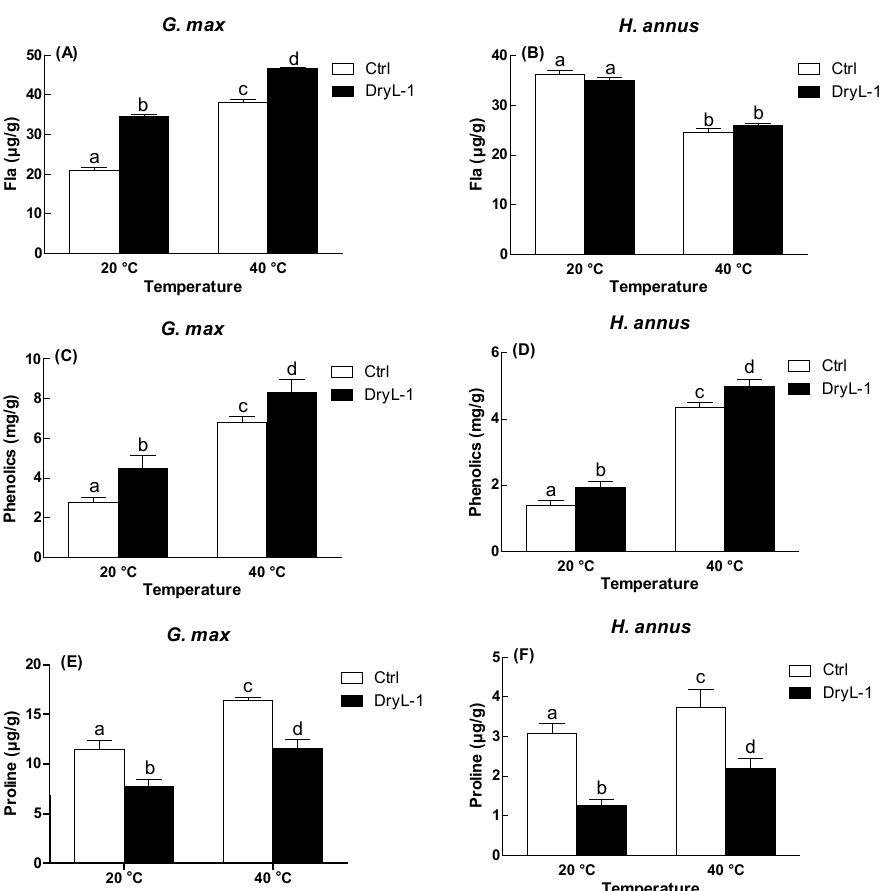
Fig. 3: Influence of A. violaceofuscus on the concentrations of flavonoids (A, B), phenolics (C, D) and proline (E, F), in G. max and H. annuus plants grown at normal (25 °C) and high (40 °C) temperatures. Data are means of triplicate with standard error bars. Different letters are significantly different (p < 0.05) as estimated by Duncan’s Multiple Range Test